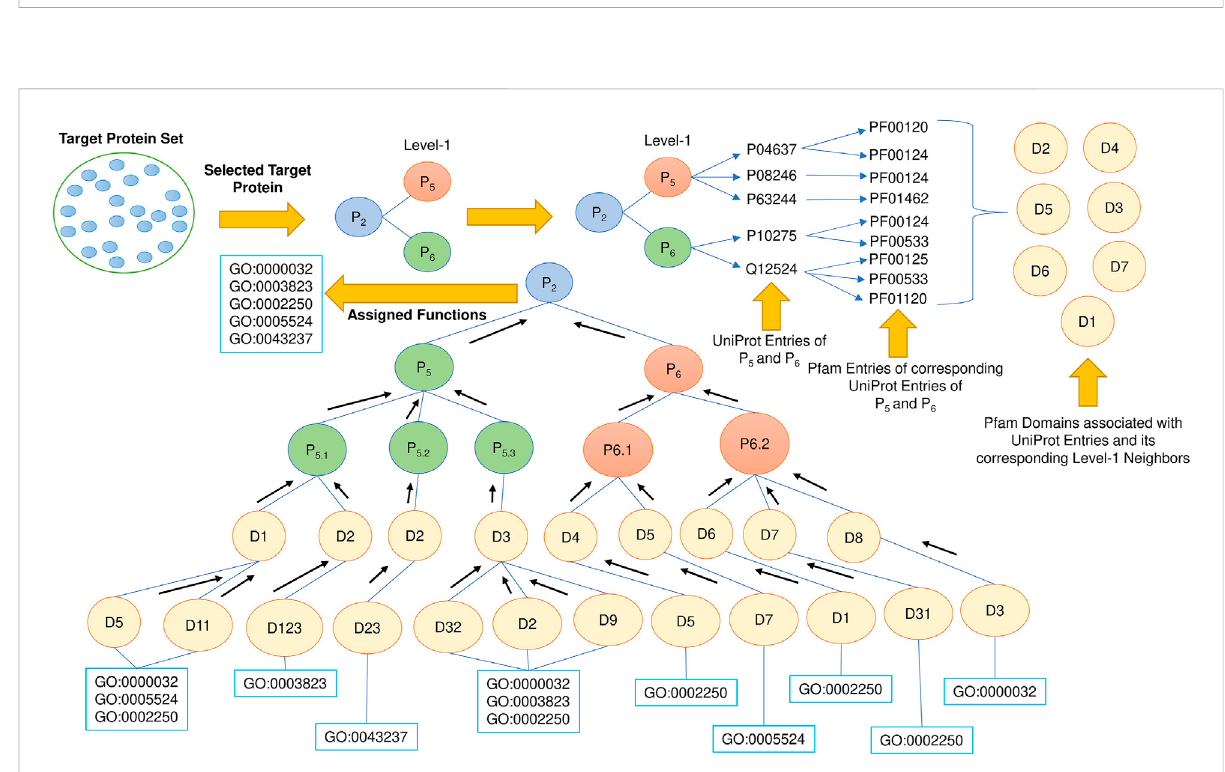
FIGURE 5 Working strategy of Domain-based protein function prediction. Four databases, String, UniProt, PFAM, and DOMINE, are used in this